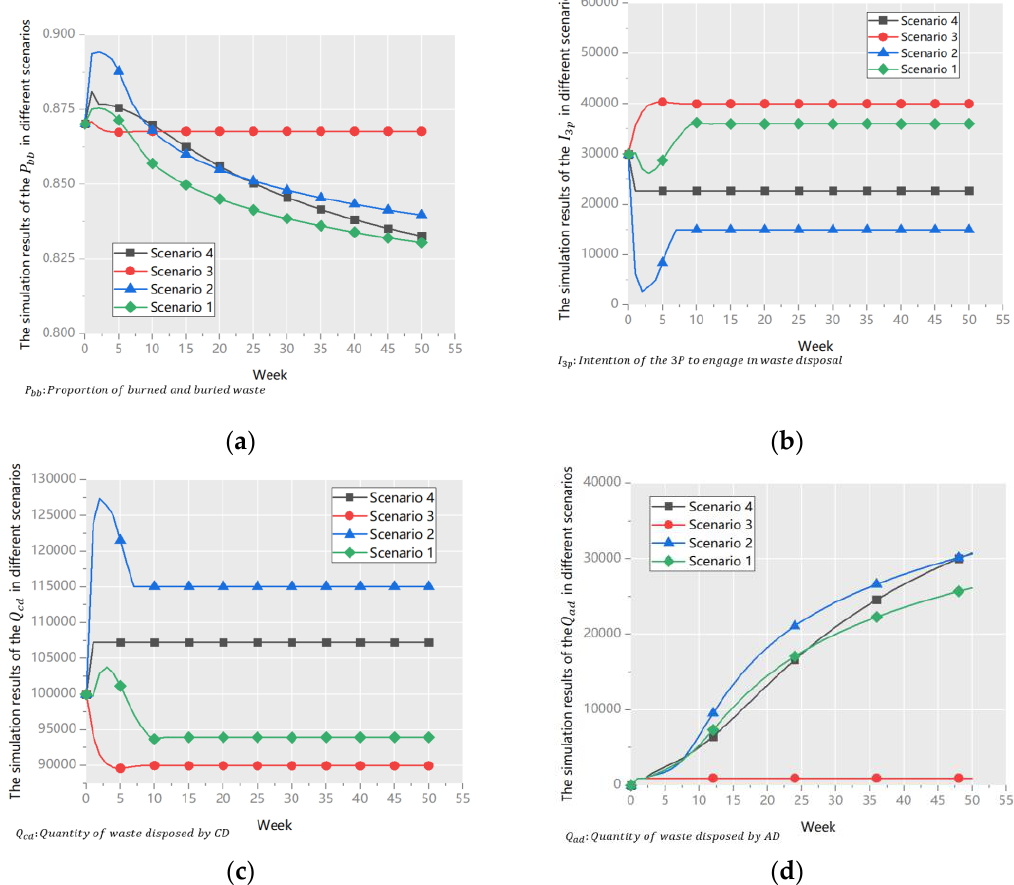
Figure 6. The simulation results of the important indicators in different scenarios:( a ) P bb ; ( b ) I 3p ; ( c ) Q cd ; ( d ) Q ad .